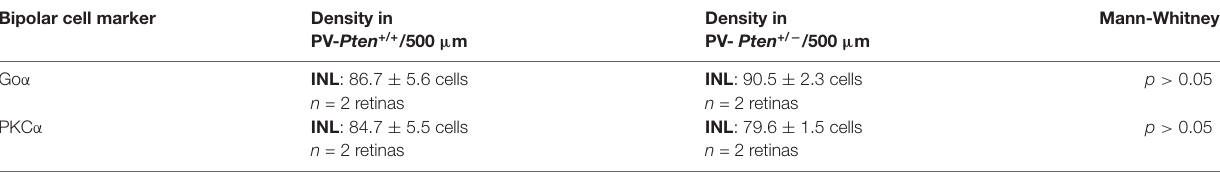
TABLE 3 | Bipolar cell populations in the PV- Pten mouse